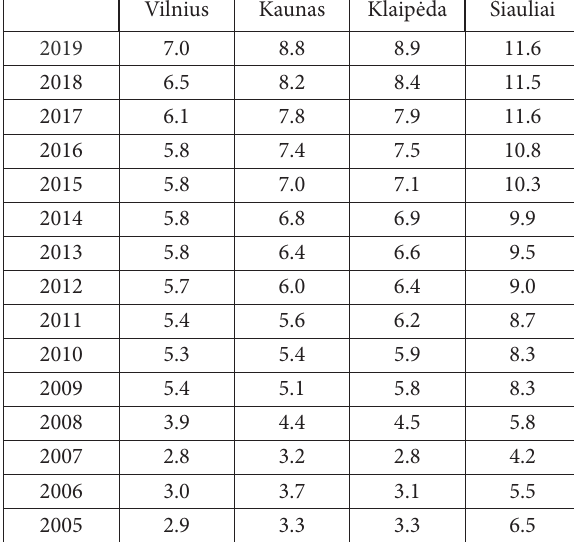
Table A2. Housing affordability (average yearly wage divided by housing price in EUR per sqm) in Lithuanian cities in